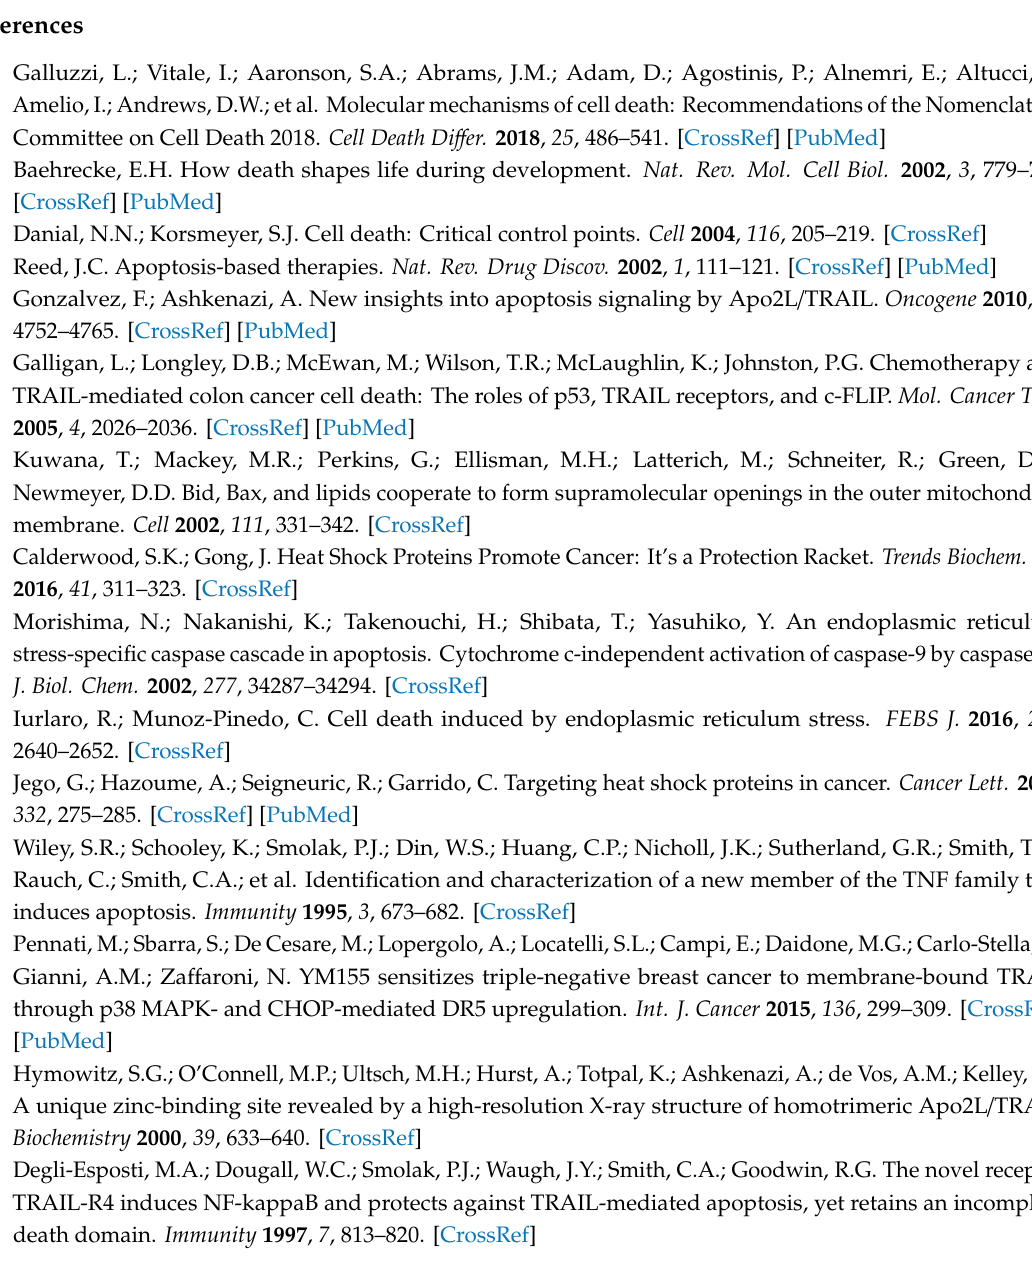
Table S1: First generation death receptor targeted therapeutics and the status of clinical trials, Table S2: MCL1 and CDK9 inhibitor to induce apoptosis, Table S3: IAP inhibitors that are currently studied in the clinic. Funding: This research was supported in part by the Intramural Research Program of the National Cancer Institute, Center for Cancer Research (S.L. and Y.G.). Conflicts of Interest: The authors declare no conflict of